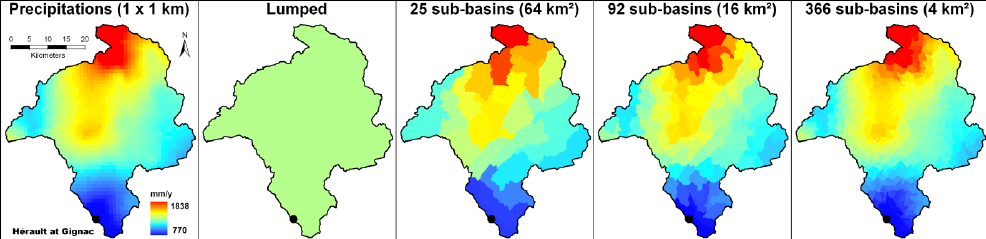
Fig. 5. Distributed precipitation forcing (10yr average) for the catchment discretizations of the Hérault catchment at Gignac (1430km 2 ) shown in Fig. Figure 5. Distributed precipitation forcing (10-year average) for the catchment discretizations 3 of the Hérault catchment at Gignac (1430 km²) shown in Figure 4. 4